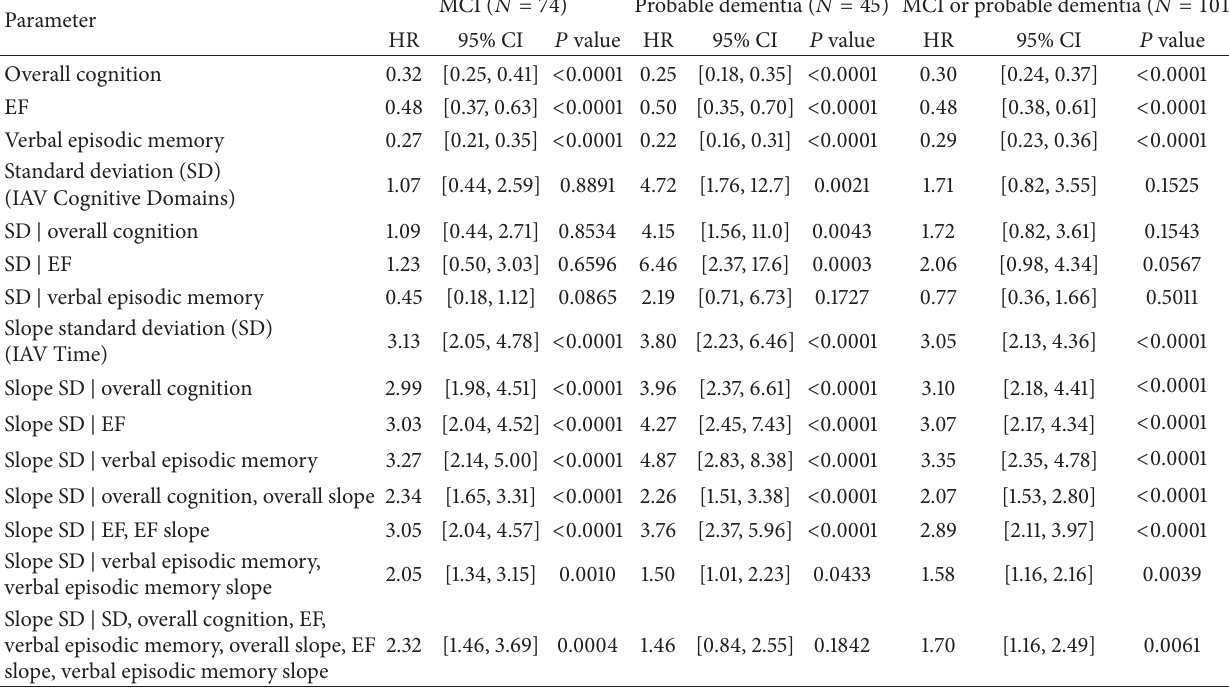
Table 3: Hazard ratios for IAV Cognitive Domains and IAV time (alone and controlling for baseline and slope overall cognition, EF, and verbal episodic memory) predicting MCI, probable dementia, and MCI or probable